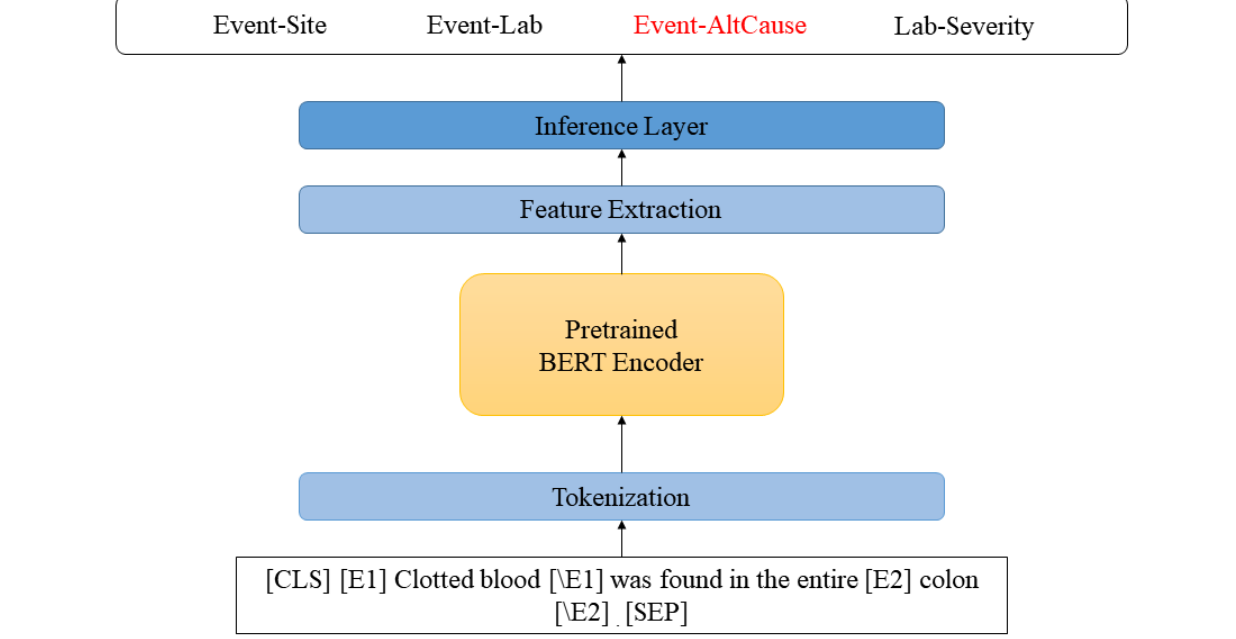
Figure 4. The high-level view of a Bidirectional Encoder Representations from Transformers (BERT)-based model. AltCause: suspected alternative